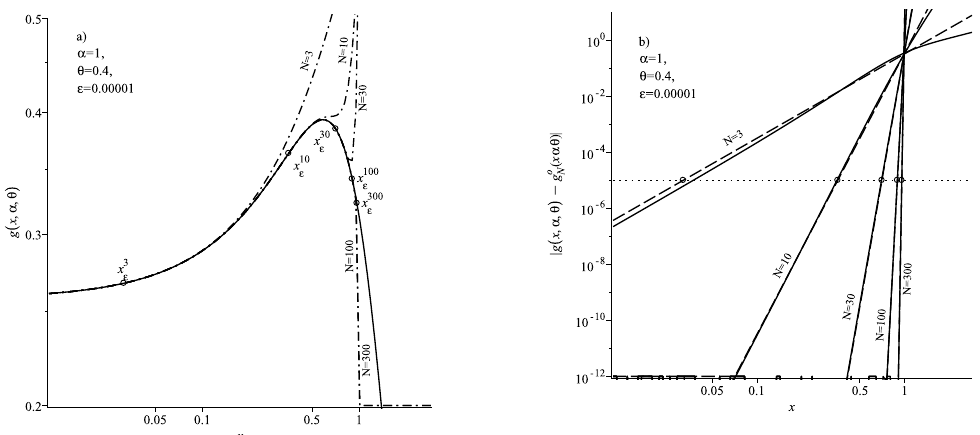
Figure 3. ( a ) Probability density g ( x , α , θ ) for the parameter values shown in the figure. A solid curve is the Formula (5), dash-dotted curves are the series (12) for different values of the number of N summands in total. Circles are the position of the threshold coordinate (36) for each value of N . ( b ) The graph of the absolute error of calculating the probability density using a series (12) for the case given in Figure ( a ). Solid curves are the exact value of the absolute error | g ( x , α , θ ) − g 0 dashed curves are the estimate (13), and the dotted line shows the position of the specified accuracy level ε . Circles demonstrate the location of the threshold coordinate (36) for the specified values of N